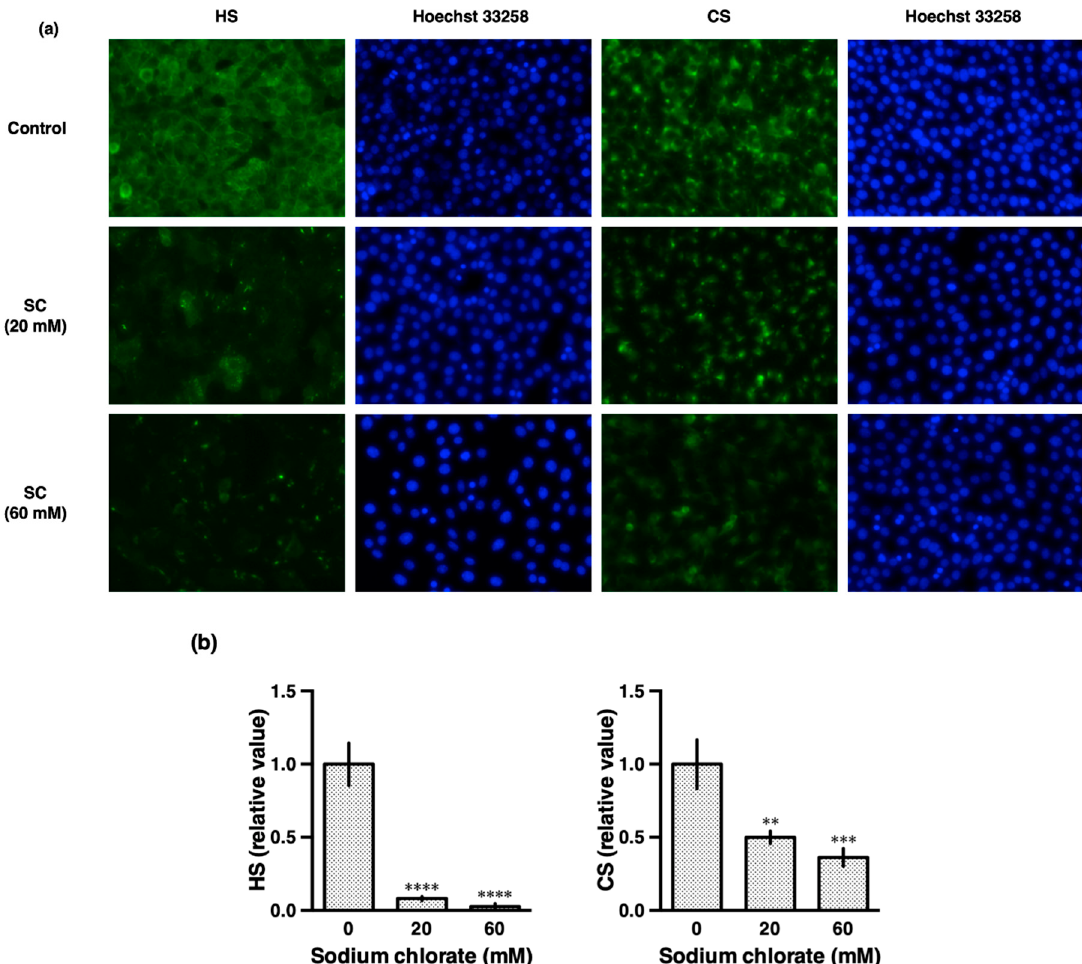
Figure 2. E ff ect of sodium chlorate on HS and CS in HT22 cells. ( a ) Representative fluorescence micrographs of typical data shown. HT22 cells were cultured with or without sodium chlorate (20 or 60 mM) for 24 h and subjected to immunofluorescent staining. HT22 cells were stained with 10E4 (anti-HS antibody) and CS-56 (anti-CS antibody). ( b ) Fluorescence intensity was quantified using a Keyence image measurement and analyzing software (VH-H1A5; Keyence). The data are presented as the mean ± SD ( n = 4). ** p < 0.01, *** p < 0.001, **** p < 0.0001 compared with the control.